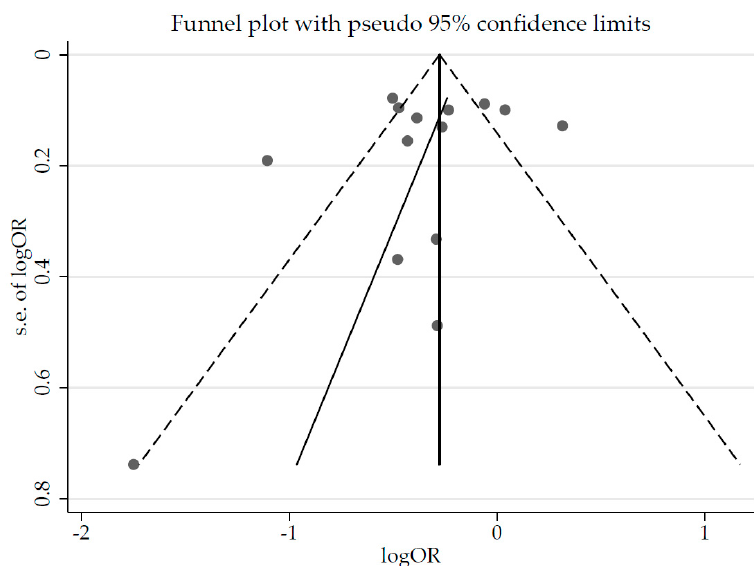
Figure 4. Funnel plot of the estimated publication bias of all studies.